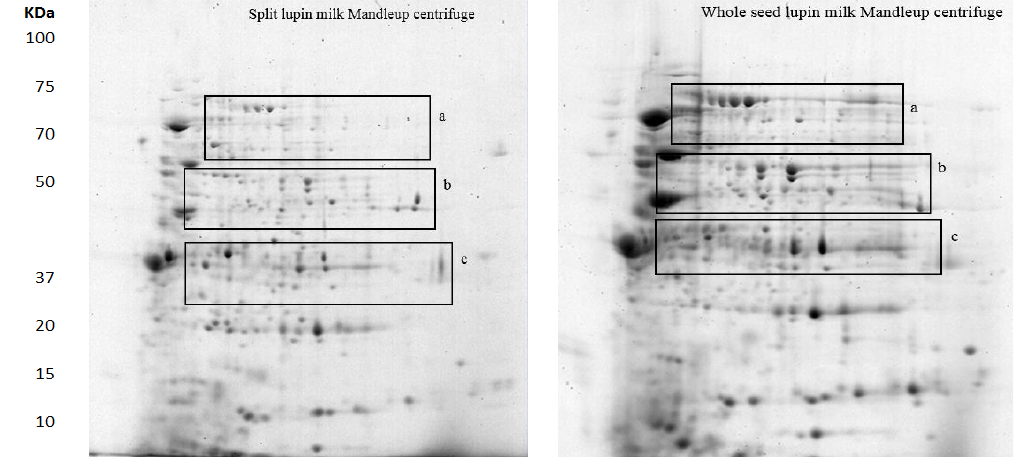
Figure 2. Lupin milk protein from whole seed and split lupin with a different processing profile of two cultivars of Lupinus angustifolius as appeared by two-dimensional gel electrophoresis signalizing overall variance of proteins in specific areas ( a – d ).